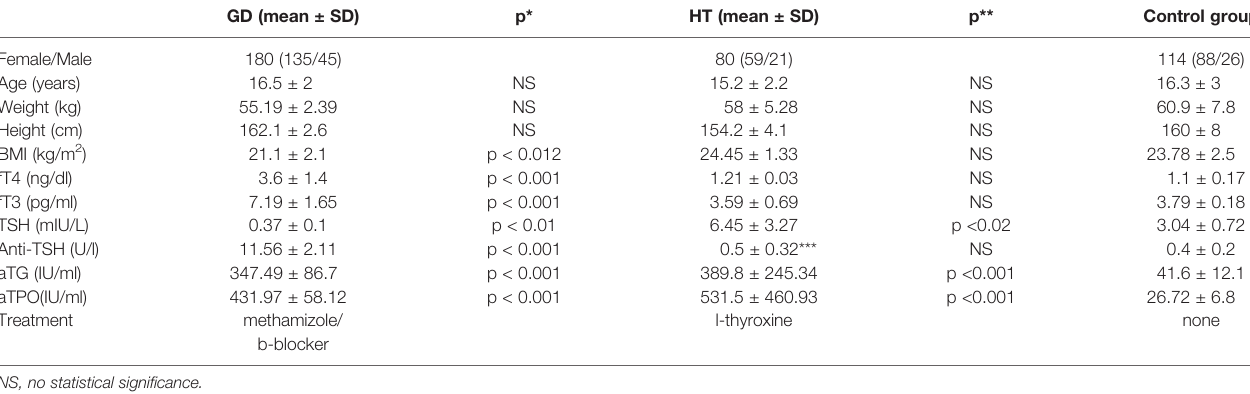
NS, no statistical signi fi cance. p*, statistical signi fi cance between patients with GD and controls. p**, statistical signi fi cance between patients with HT and controls. anti-TSH***, anti-TSH antibodies levels were analyzed in a selected group of HT patients. (n =